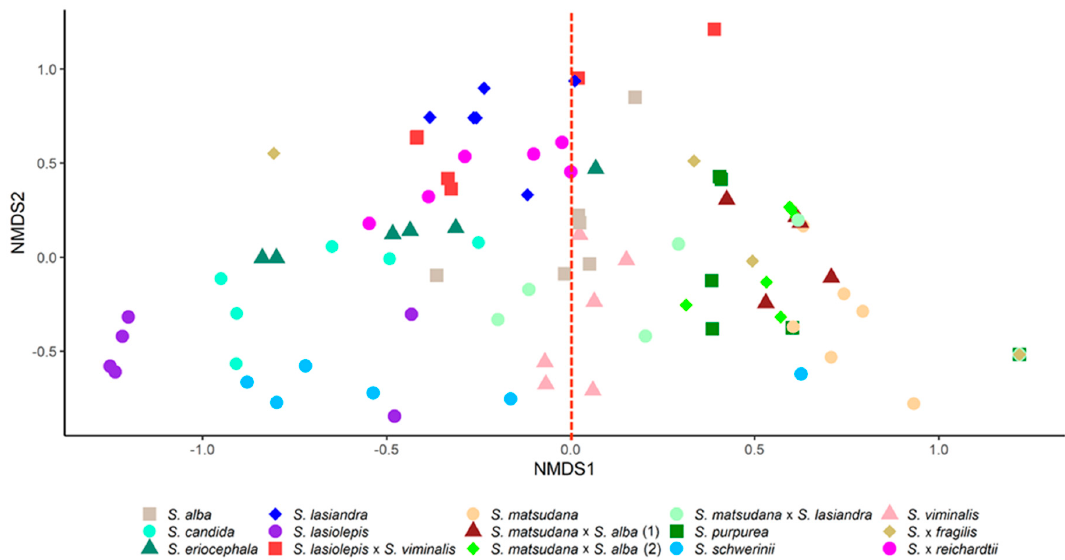
Figure 2. Non-metric Multi-Dimensional Scaling (NMDS) plot of similarities in VOC profiles released by the fifteen willow species and hybrids. Bray–Curtis dissimilarities were calculated on the square-root transformed VOC profiles containing 19 compounds. Each point represents a headspace sample (replicate). Most samples at the left side of the vertical dotted line correspond to shrub willows, whereas most samples at the right of the dotted line are tree willows.